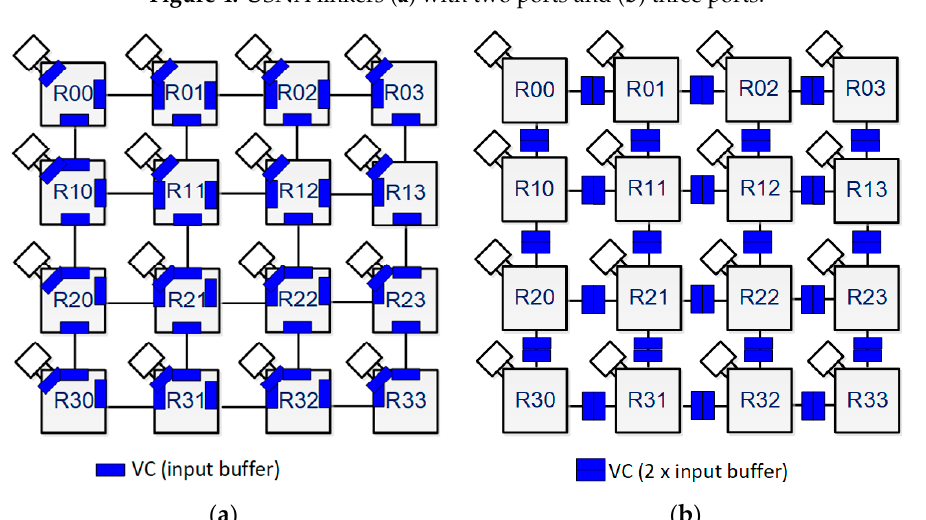
Figure 5. ( a ) 4 × 4 conventional mesh NoC and ( b ) USNA (5-port) mesh NoC with the same number of routers.